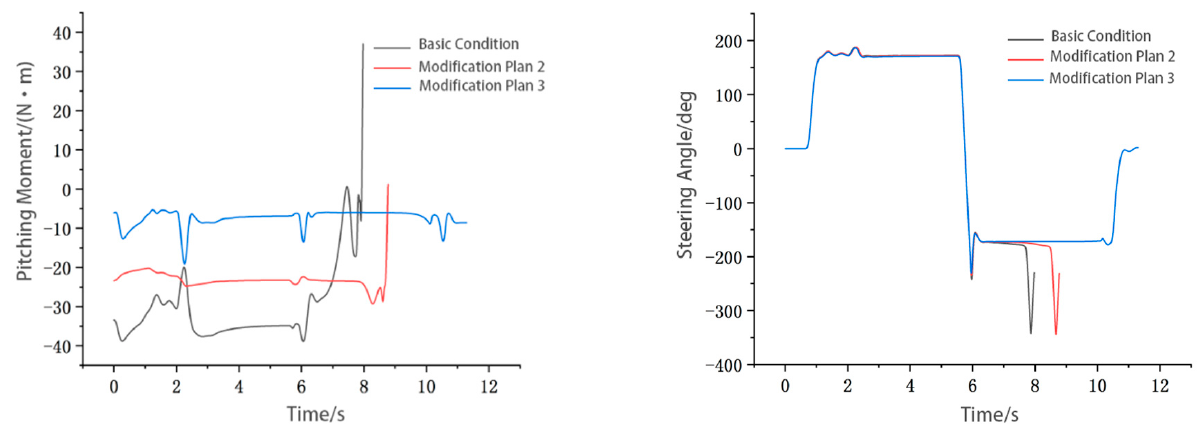
Figure 25. Comparison curve of pitching moment and steering-wheel angle.